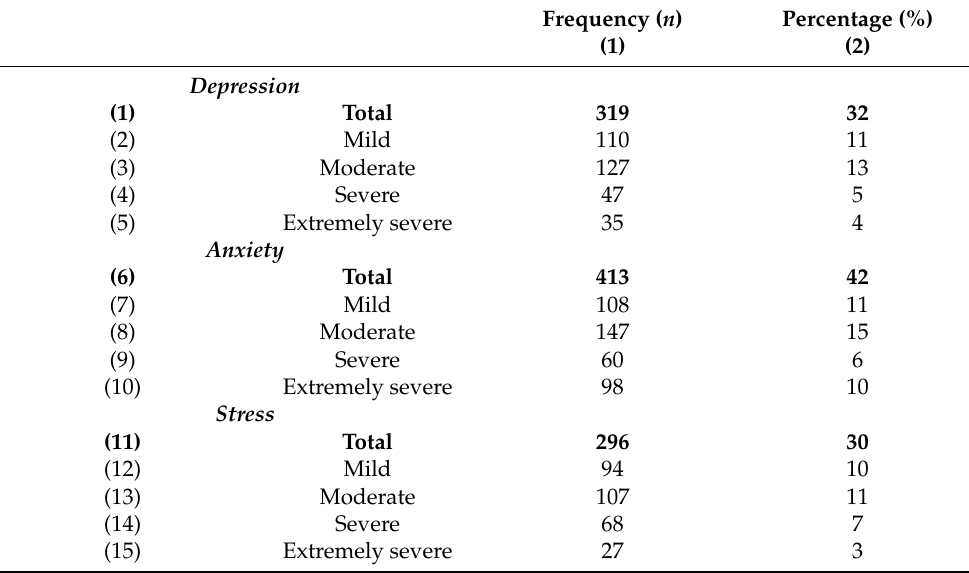
Table 2. Mental health severity in caregivers, n =